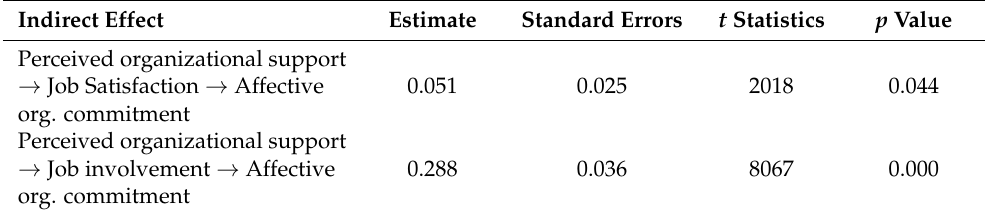
Table 3. Bootstrap results for indirect